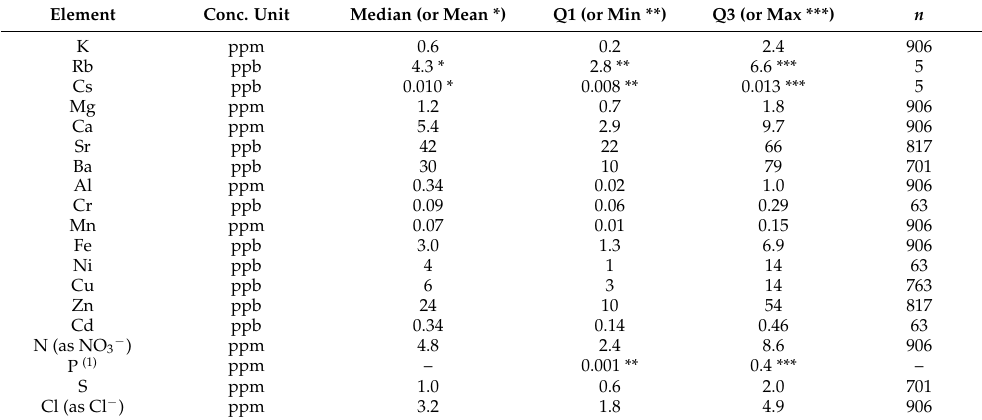
Table A1. Concentrations of elements in the soil solutions from the granite areas of Mt. Tsukuba.